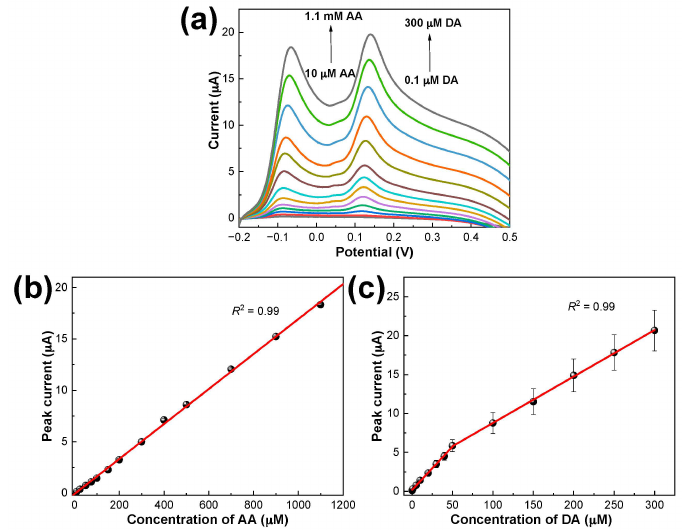
Figure 5. LSV curves of PD b S–rGO/SPCE in ( a ) 10 µ M to 1.1 mM AA and 0.1 µ M to 300 µ M DA prepared in 50 mM PBS (pH 7.0); ( b , c ) Plots of the anodic peak current against the concentrations of AA and DA,